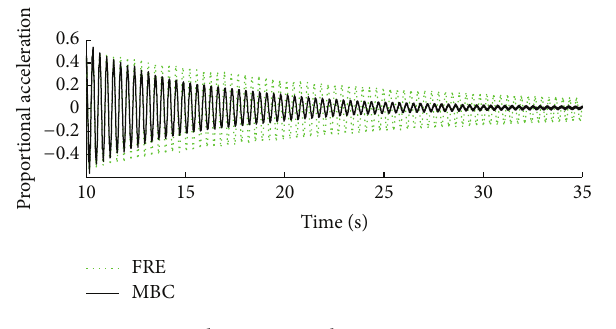
Figure 6: Acceleration time-history response curve.